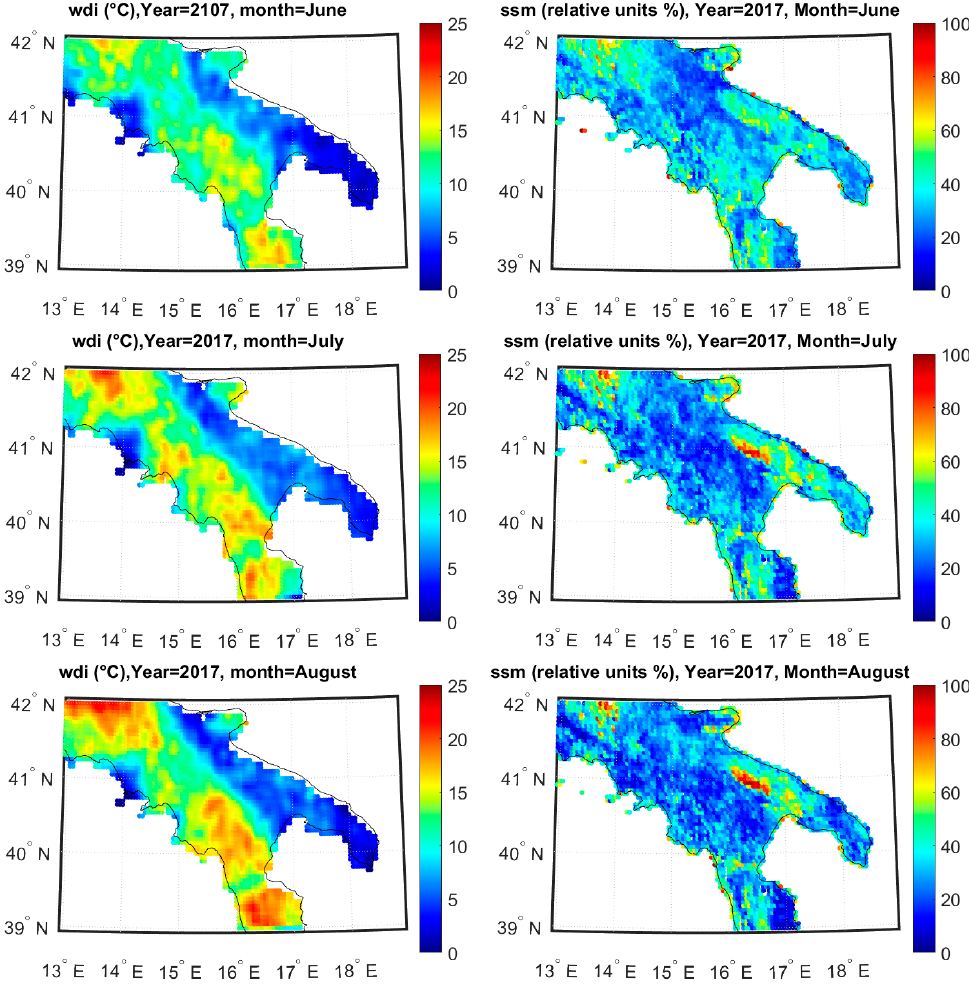
Figure 8. Comparison of ssm vs. wdi for the period of June to August in 2017. Top to bottom, June to August.